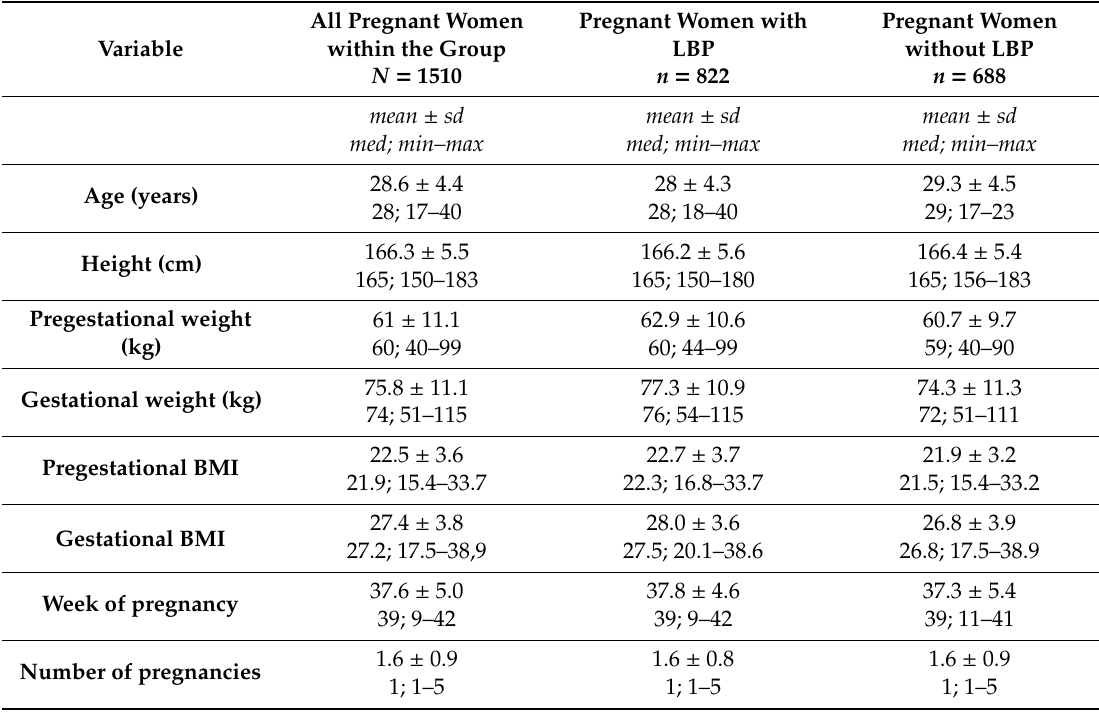
Table 1. Participant